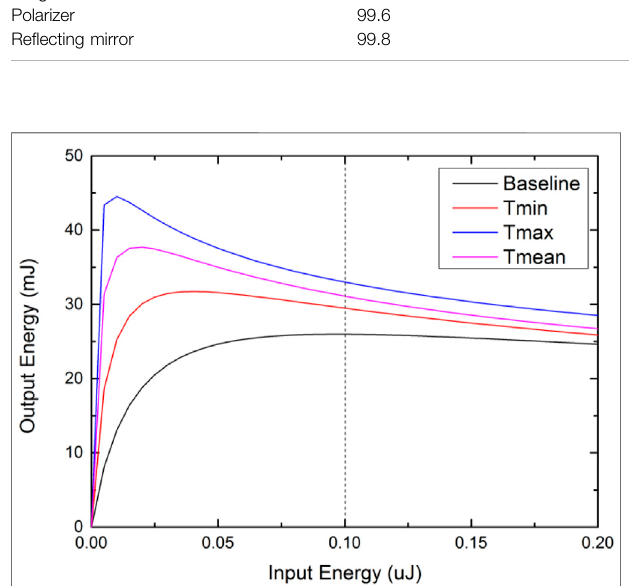
FIGURE 2 | Energy curves of different con fi gurations.